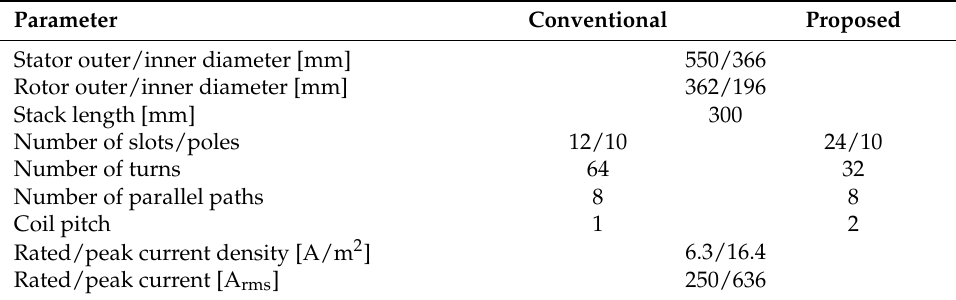
Table 2. Specifications of the conventional and proposed